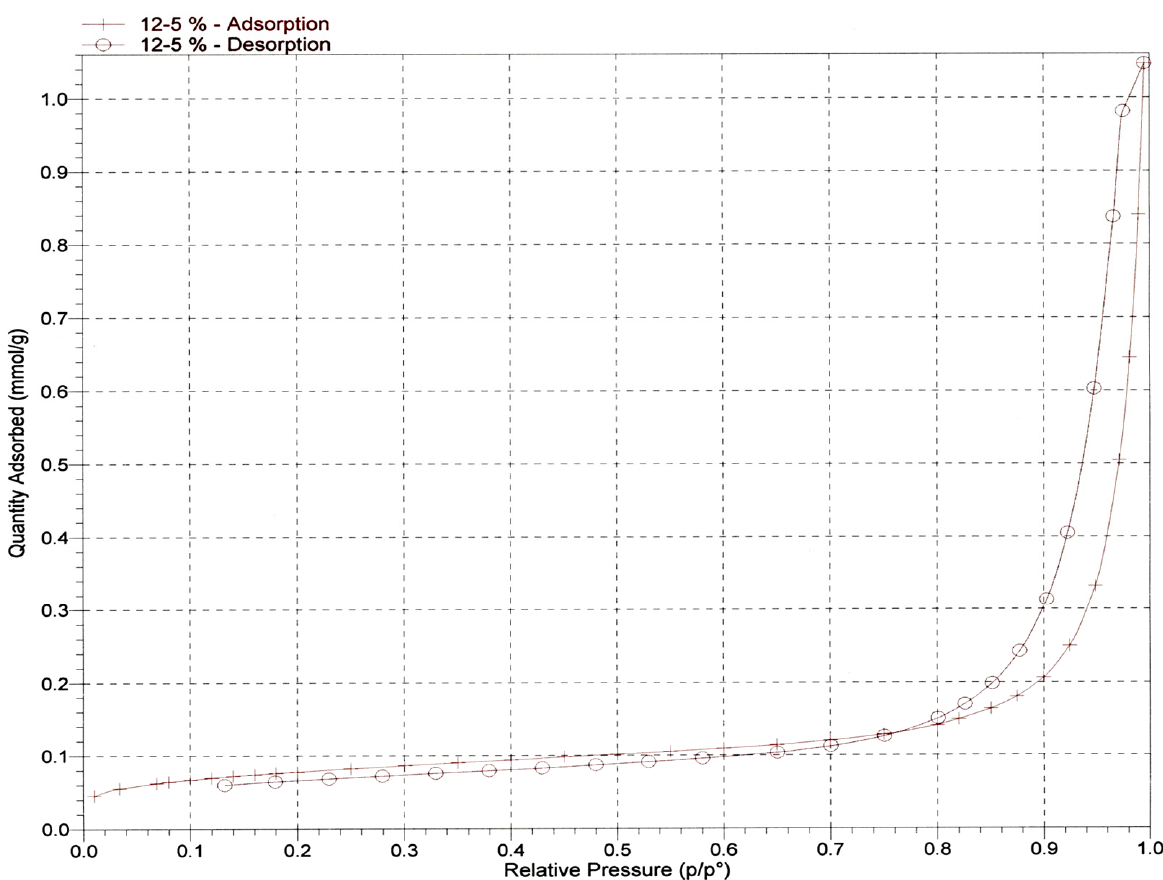
Figure 6. Nitrogen adsorption/desorption isotherms. Table 1. The average pore size.